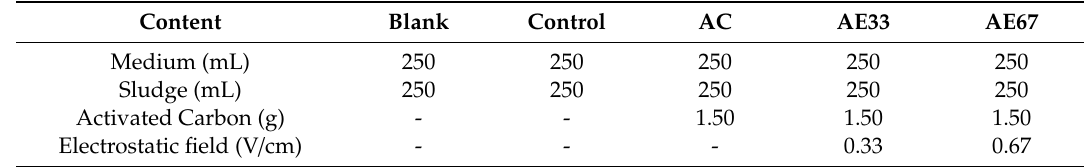
Table 1. Experimental conditions for the bioelectrochemical coal conversion to